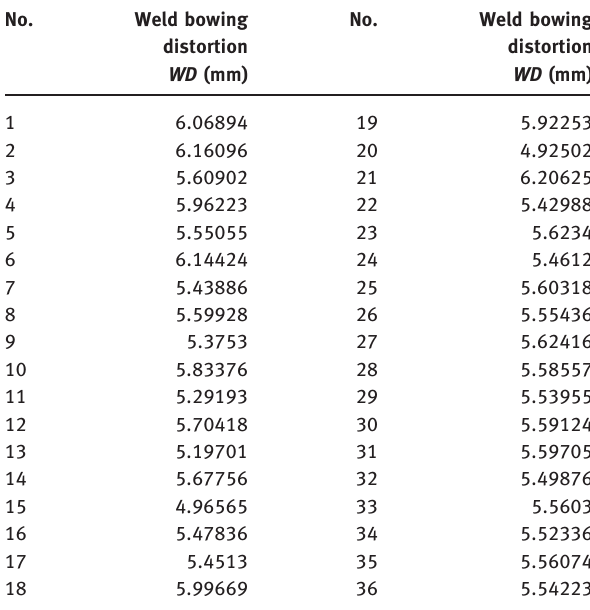
Table 4: Measured weld bowing distortion for central composite rotatable design matrix.